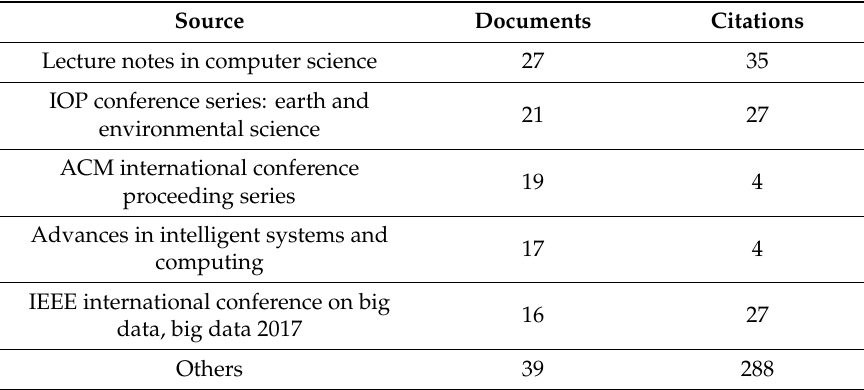
Table 4. Top sources based on number of papers reviewed from 2010–2020.